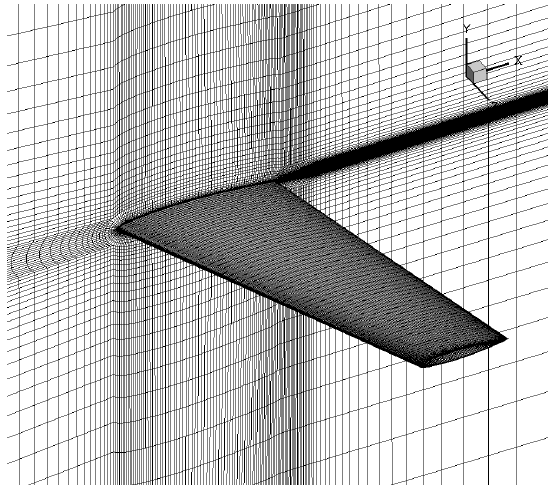
Figure 20. Mesh for calculation of transonic ONERA M6 3D